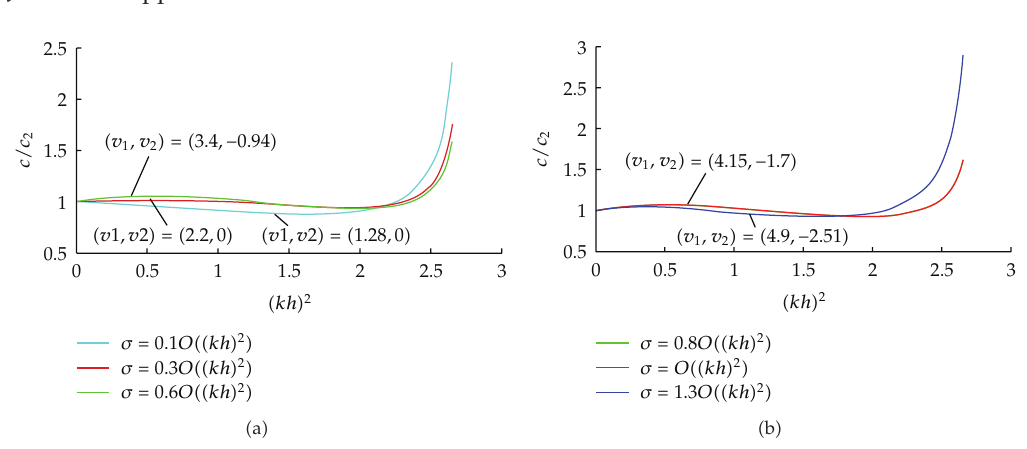
Figure 4: Comparison of wave celerity for dispersive and nonlinear of the same order σ (cid:7) O (cid:2) μ (cid:3) .